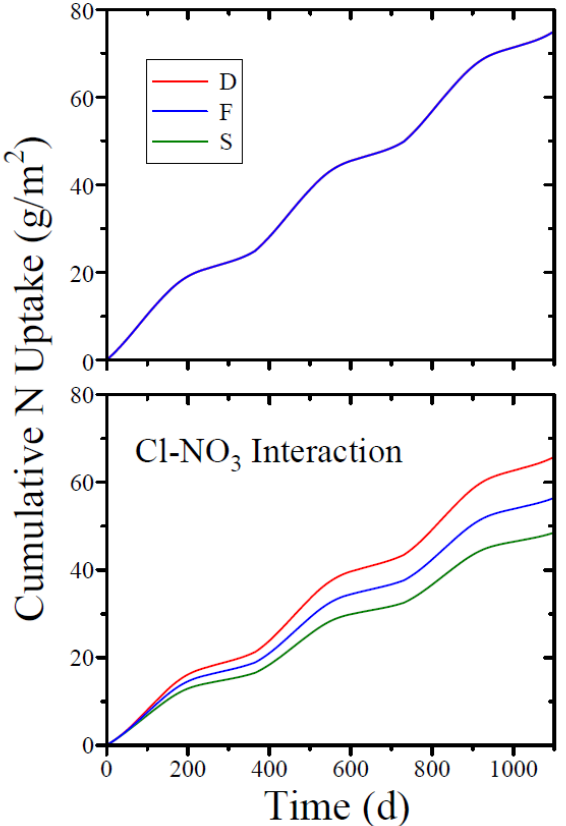
Figure 7. Cumulative mass of N extracted by the trees’ roots as a function of time, for the different scenarios examined. Top panel — the effect of the competition between nitrate and chloride on N uptake was disregarded.